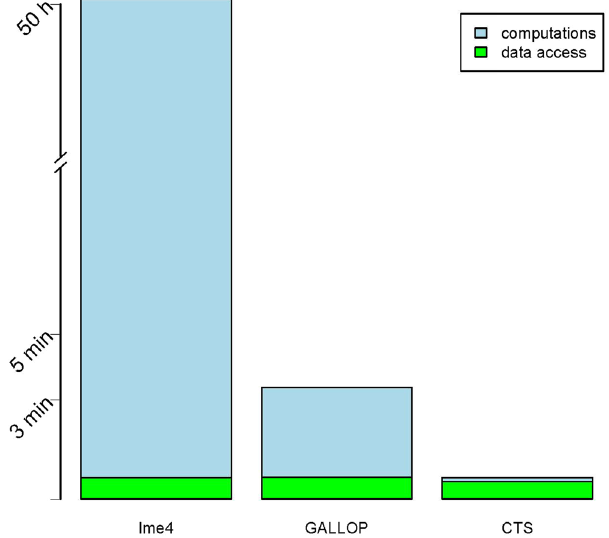
Figure 5. Time of the genome-wide analysis of the BMD data, 97384 SNPs from chromosome 22. Time spent on data access and time spent on computations are